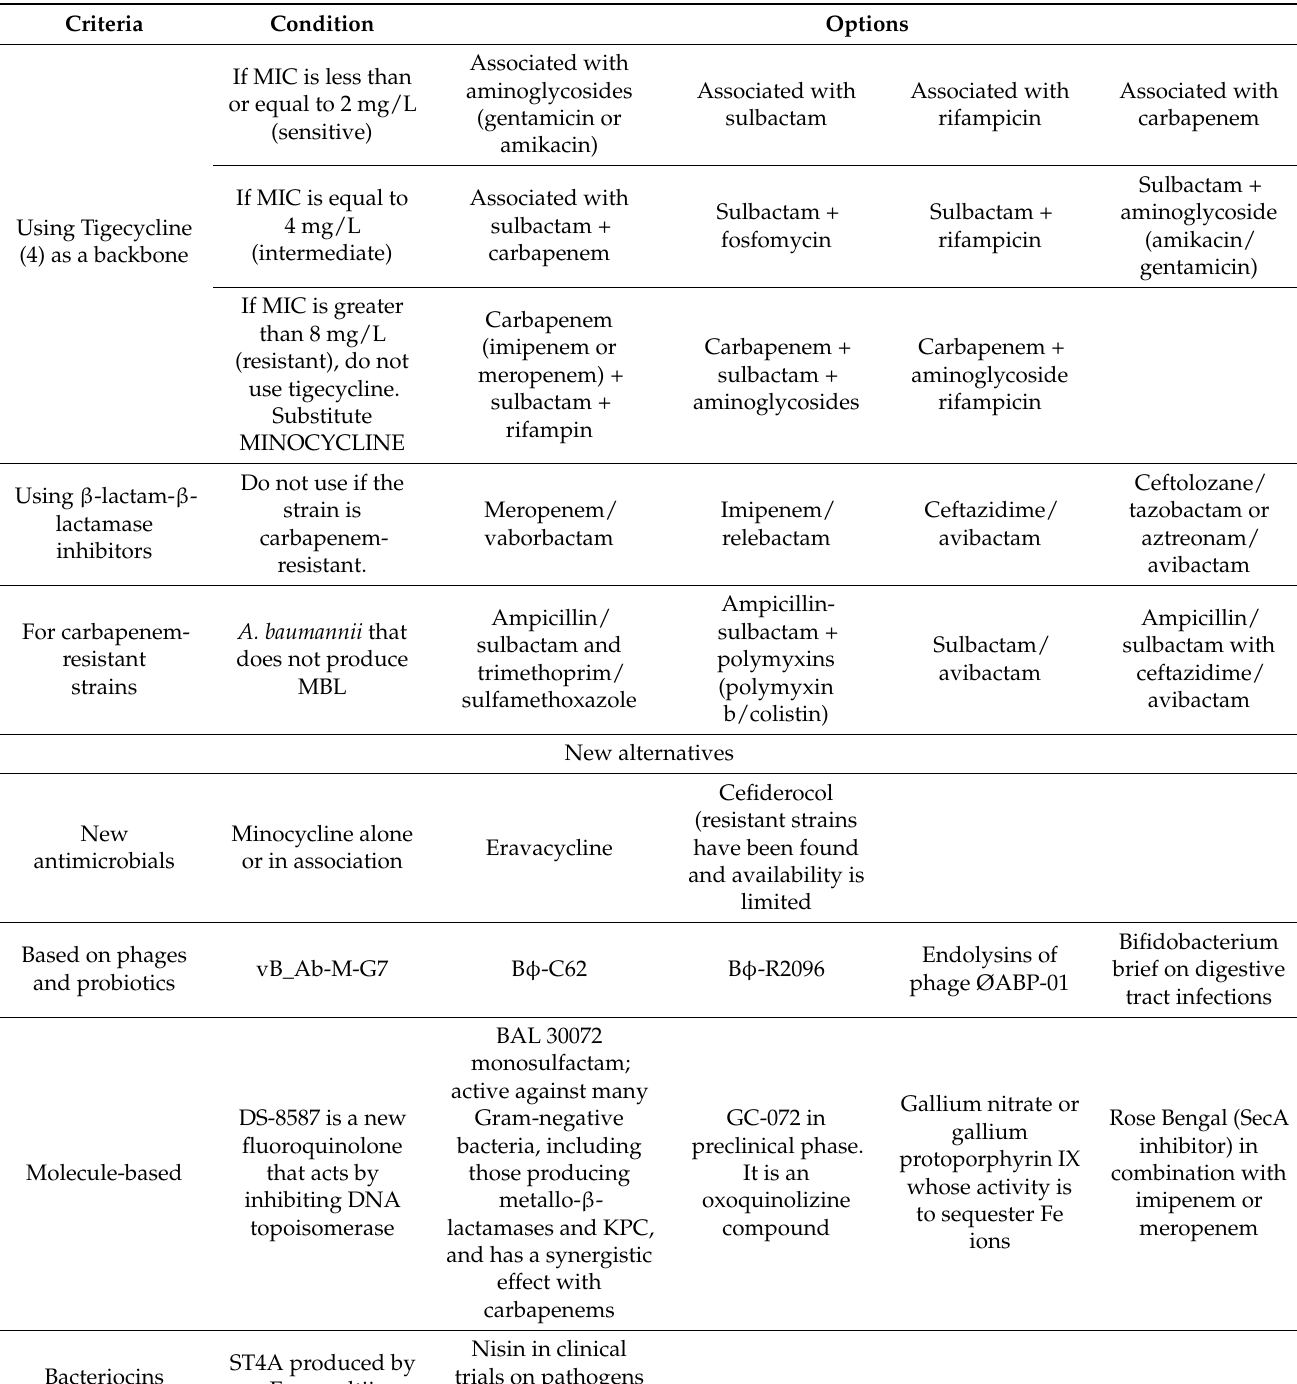
Table 2. Possible therapies against A. baumannii